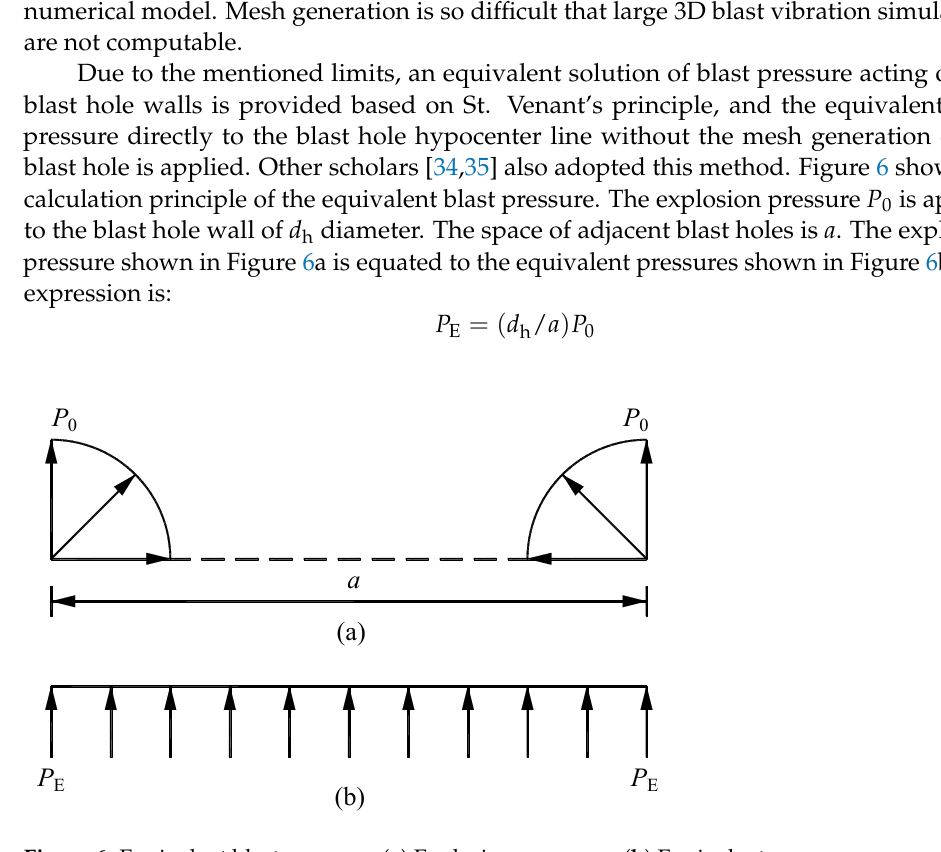
Figure 6. Equivalent blast pressure. ( a ) Explosion pressures; ( b ) Equivalent pressures